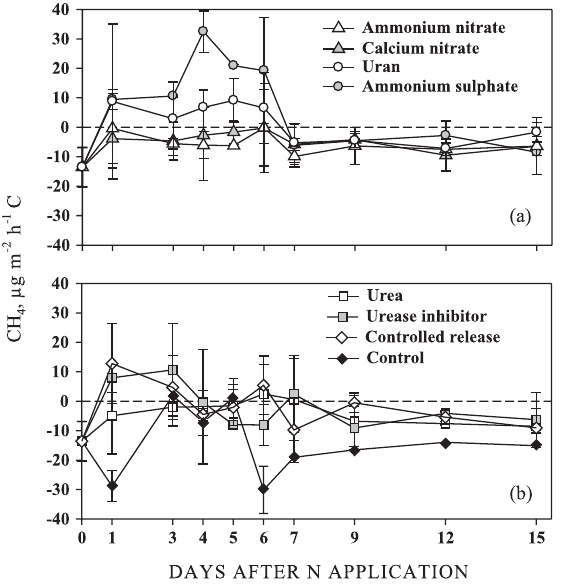
Figure 3. Daily fluxes of CH from soil ( μ g m -2 h -1 C) 4 for the 15 day period after application of the nitrogen fertilizers to a Gleysol in the South of Brazil. Vertical bars mean standard deviation of the mean ( n